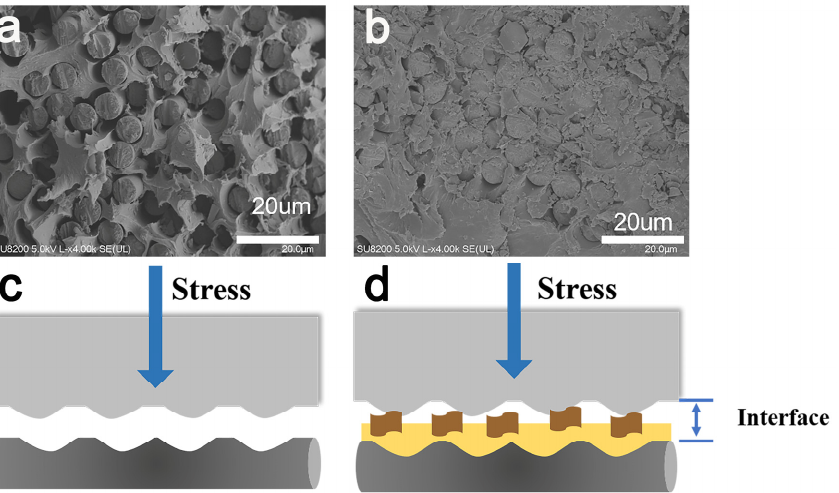
Figure 10. SEM morphologies of the flexural fracture surface of ( a ) Untreated CF/PPEK; ( b ) CF- KHN + -4GO/PPEK; Proposed failure mechanism of composites: ( c ) Untreated CF/PPEK, ( d ) CF- KHN + -4GO /PPEK.